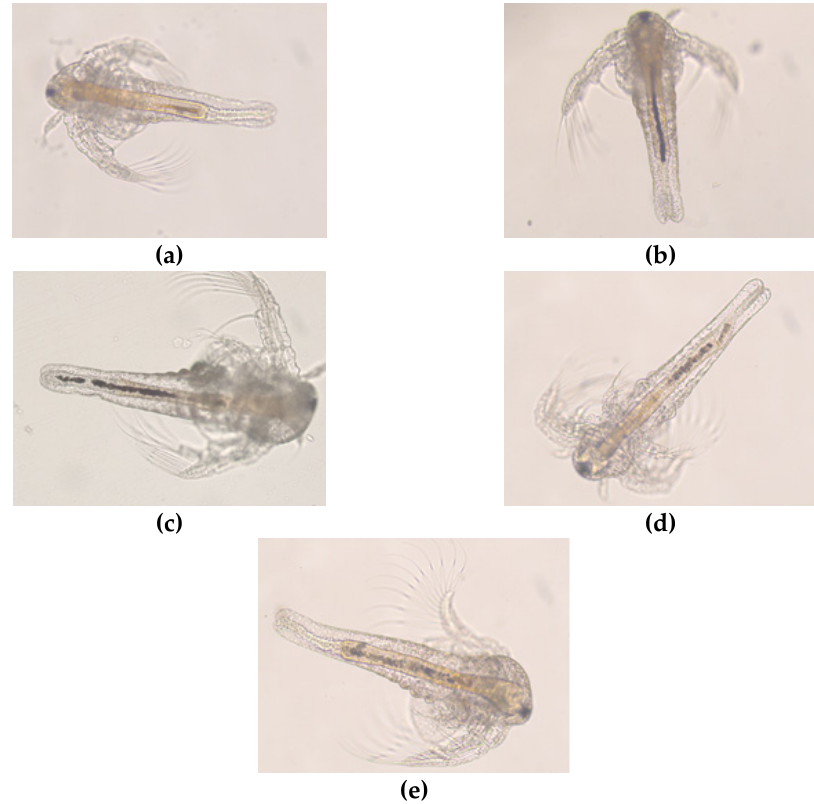
Figure 10. Artemia nauplii . Untreated (ctrl) ( a ); nauplii exposed to TiO 2 -rGO at 2% for 48 h at different concentration: 10 − 1 ( b ), 10 − 2 ( c ), 10 − 3 ( d ), 10 − 4 ( e ). concentration: 10 − 1 ( b ), 10 − 2 ( c ), 10 − 3 ( d ), 10 − 4 ( e